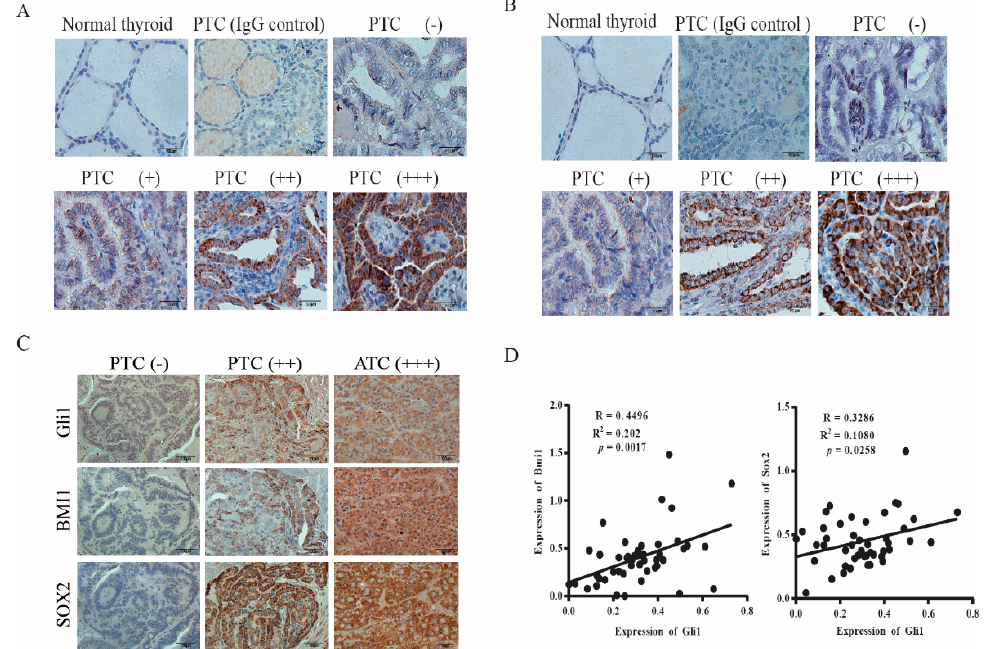
Figure 6. SOX2 and BMI1 expression in thyroid cancer. The sections of paraffin-embedded tissue blocks were analyzed for BMI1 ( A ) and SOX2 ( B ) expression by immunohistochemical (IHC) staining with their specific antibodies. A representative of normal thyroid follicles and papillary thyroid carcinoma (PTC) with different expression levels is given. Normal rabbit IgG was included as a negative control. BMI1 and SOX2 expression in a representative PTC graded as negative ( − ), positive (+), strongly positive (++), and very strongly positive (+++) is shown. Scale bar, 50 mm. ( C ) Concomitant expression of Gli1 with SOX2 and BMI1. The consecutive sections of PTC and anaplastic thyroid carcinoma (ATC) specimens were immunostained with antibodies against Gli1, BMI1, and SOX2. Scale bar, 100 mm. ( D ) The signals of Gli1, SOX2, and BMI1 staining in the images taken from the consecutive sections of 46 PTC specimens were quantified by using an Imageproplus software. The arbitrary units of the staining signals were plotted in dot graphs. Table 2. BMI1 and SOX2 expression in thyroid papillary carcinomas.